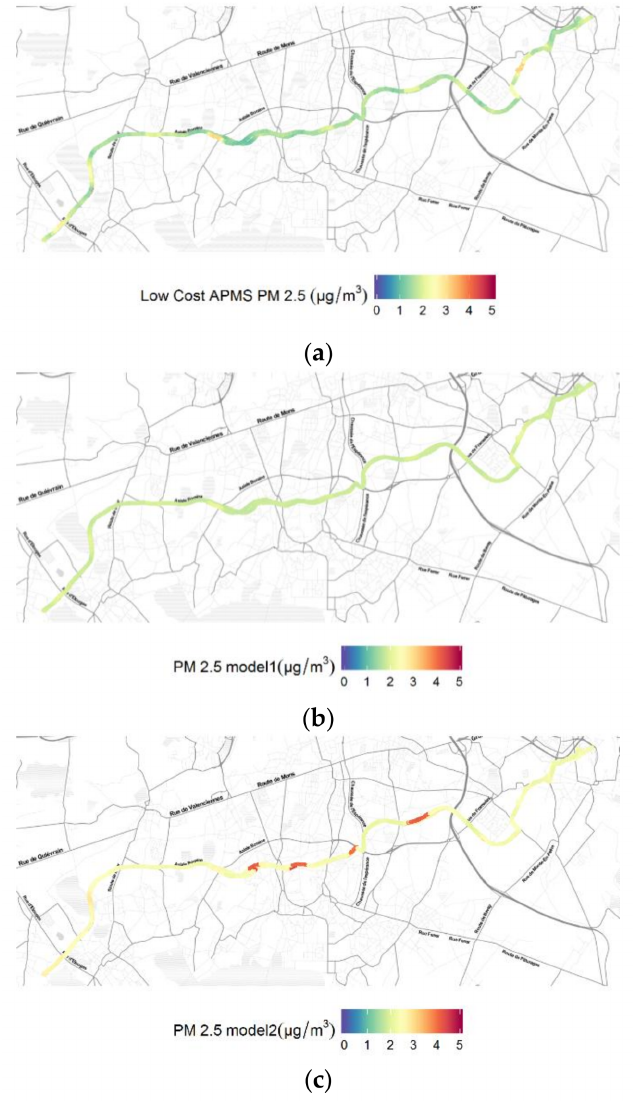
Figure 12. Heat maps of PM2.5 concentrations during the e-bike run at the outskirts of Mons on 6 August 2017: ( a ) Raw measurements of the on-board PM sensor; ( b ) Output of linear regression model 1; ( c ) Output of linear regression model